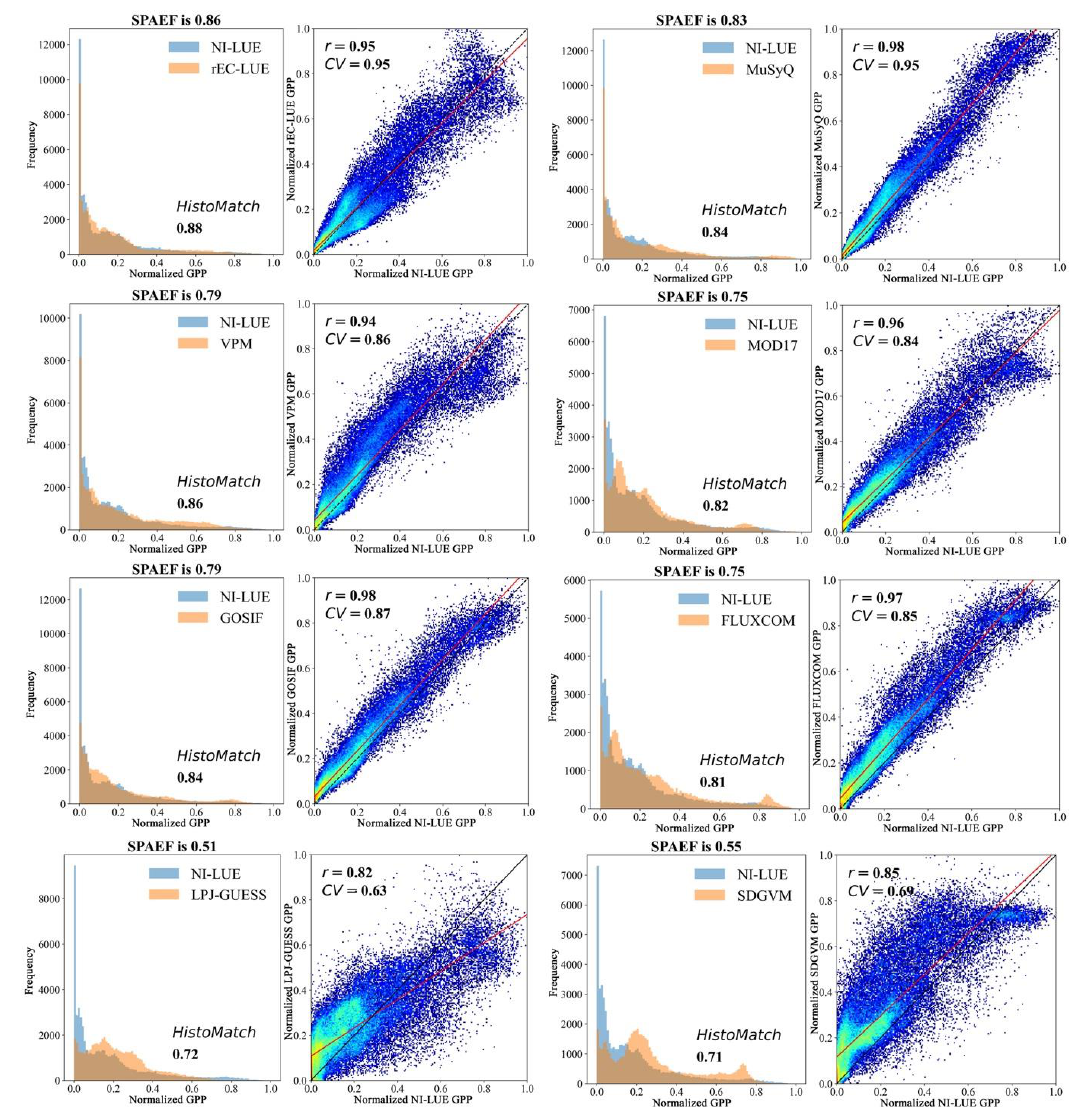
Figure 14. SPAtial Efficiency (SPAEF) between NI-LUE GPP and different GPP products.